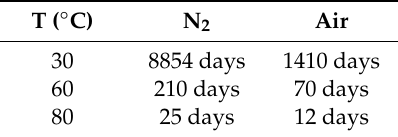
Table 1. Half-life time of the perovskite in the blend under continuous operation at the indicated